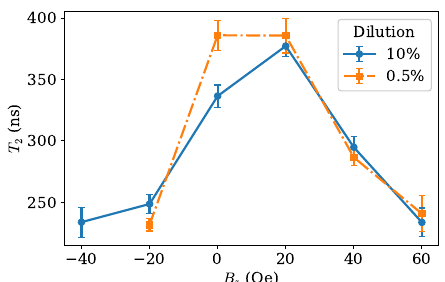
Figure 5. T 2 as a function of applied field for 10% (blue circles, at 4.43 GHz) and 0.5% (orange squares, at 4.50 GHz) samples. The apparent offset of the peaks from 0 Oe is due to remnant field in our magnet. The lines connecting datapoints are guides to the